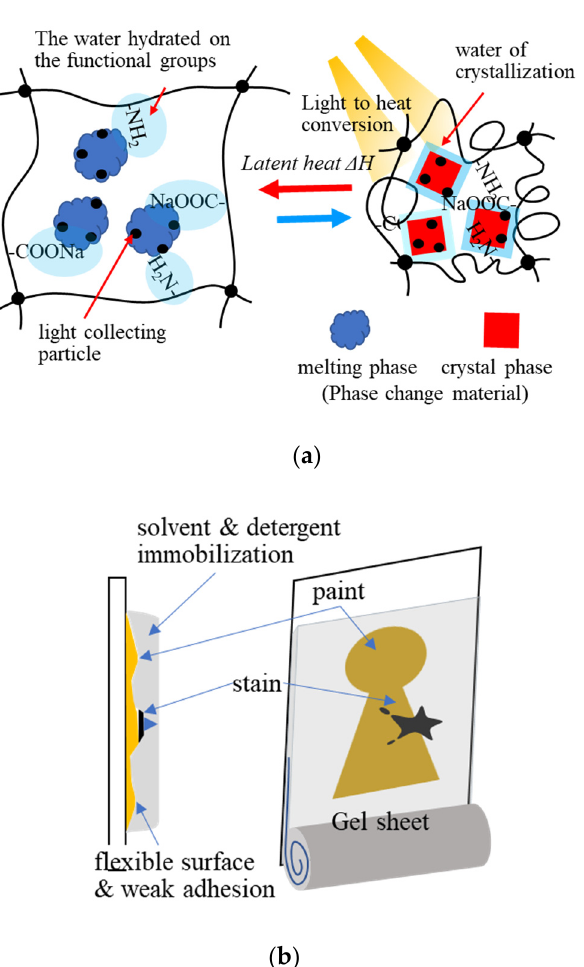
Figure 8. Application of the hydrogel adsorbents: ( a ) heat accumulation with light-to-thermal conversion, ( b ) conservation science: schematic image of the gel cleaning for painting art restoration.